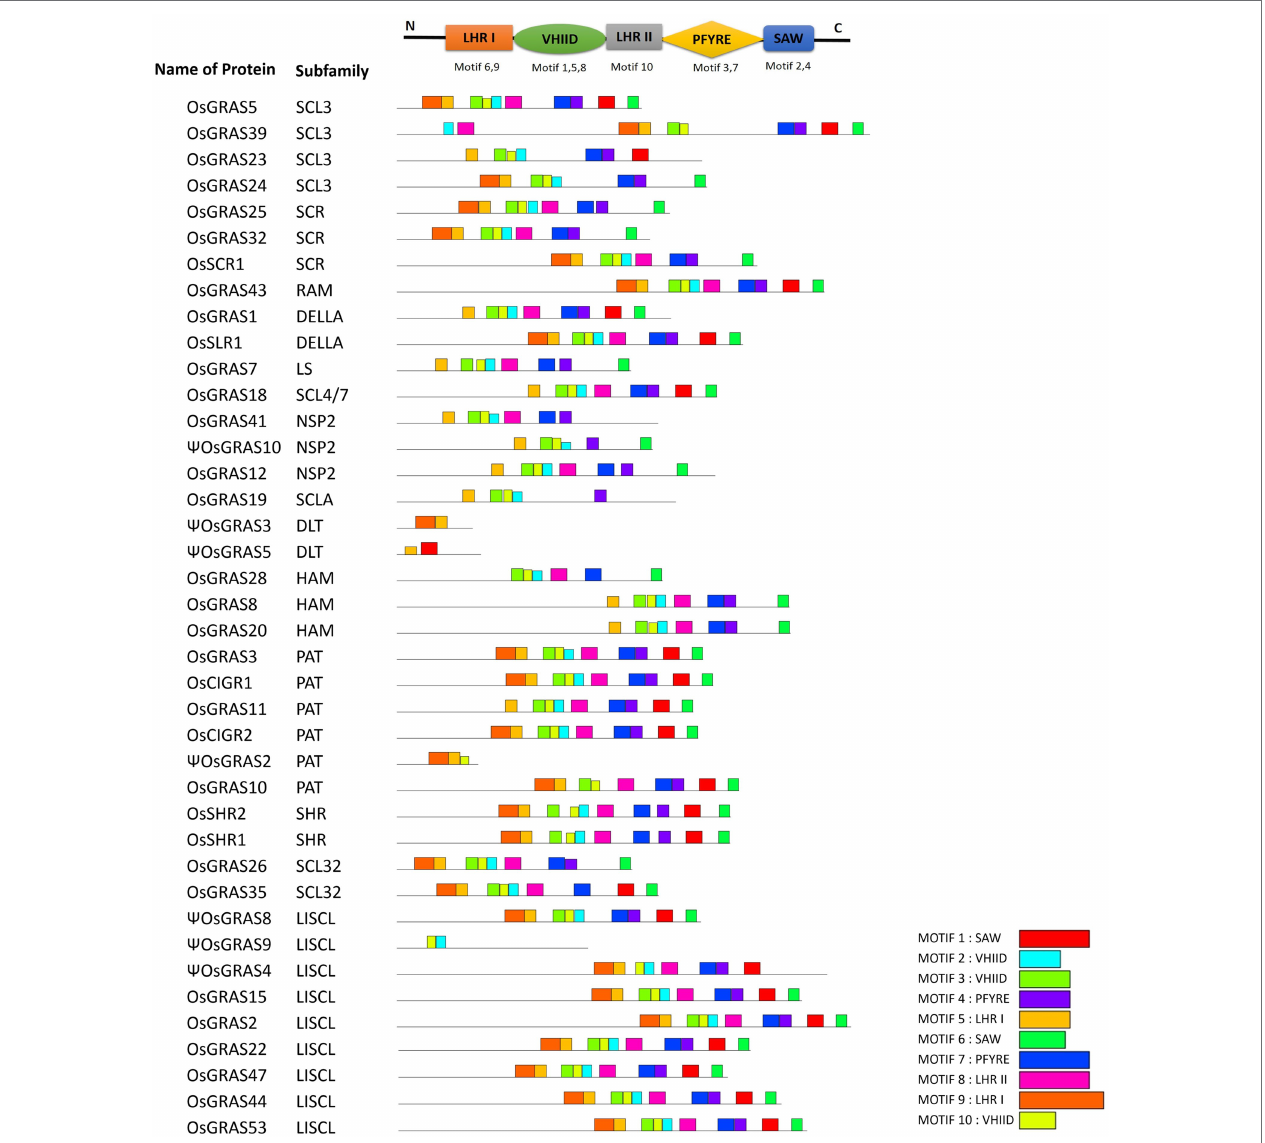
FIGURE 3 | MEME-motif analysis of OsGRAS genes. Figure showing the identified MEME-motifs of OsGRAS genes. The conserved GRAS-motifs are provided at the top. A search for 10 MEME-motifs was done and each of them has been assigned to the corresponding GRAS-motifs. Each coloured box represents one motif and the legend has been provided below. The genes were organized based on their